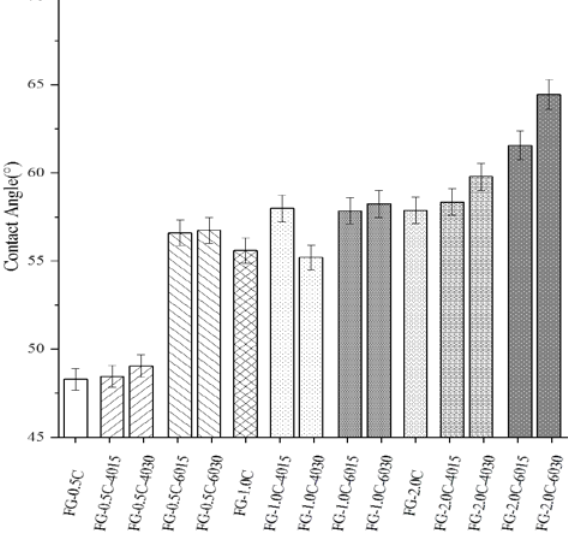
Figure 2. Effect of sonication on contact angle results of flaxseed gum films incorporated with carvacrol (The bars with the same pattern had the same carvacrol concentration and sonication power).